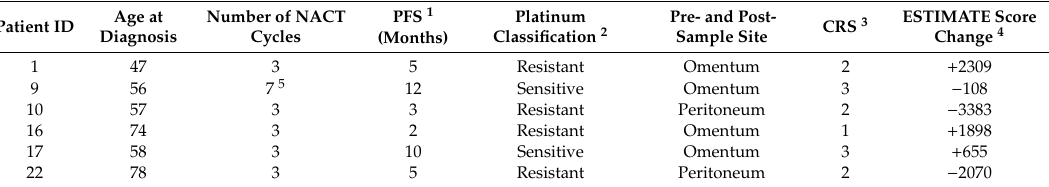
Table 1. Patient characteristics.